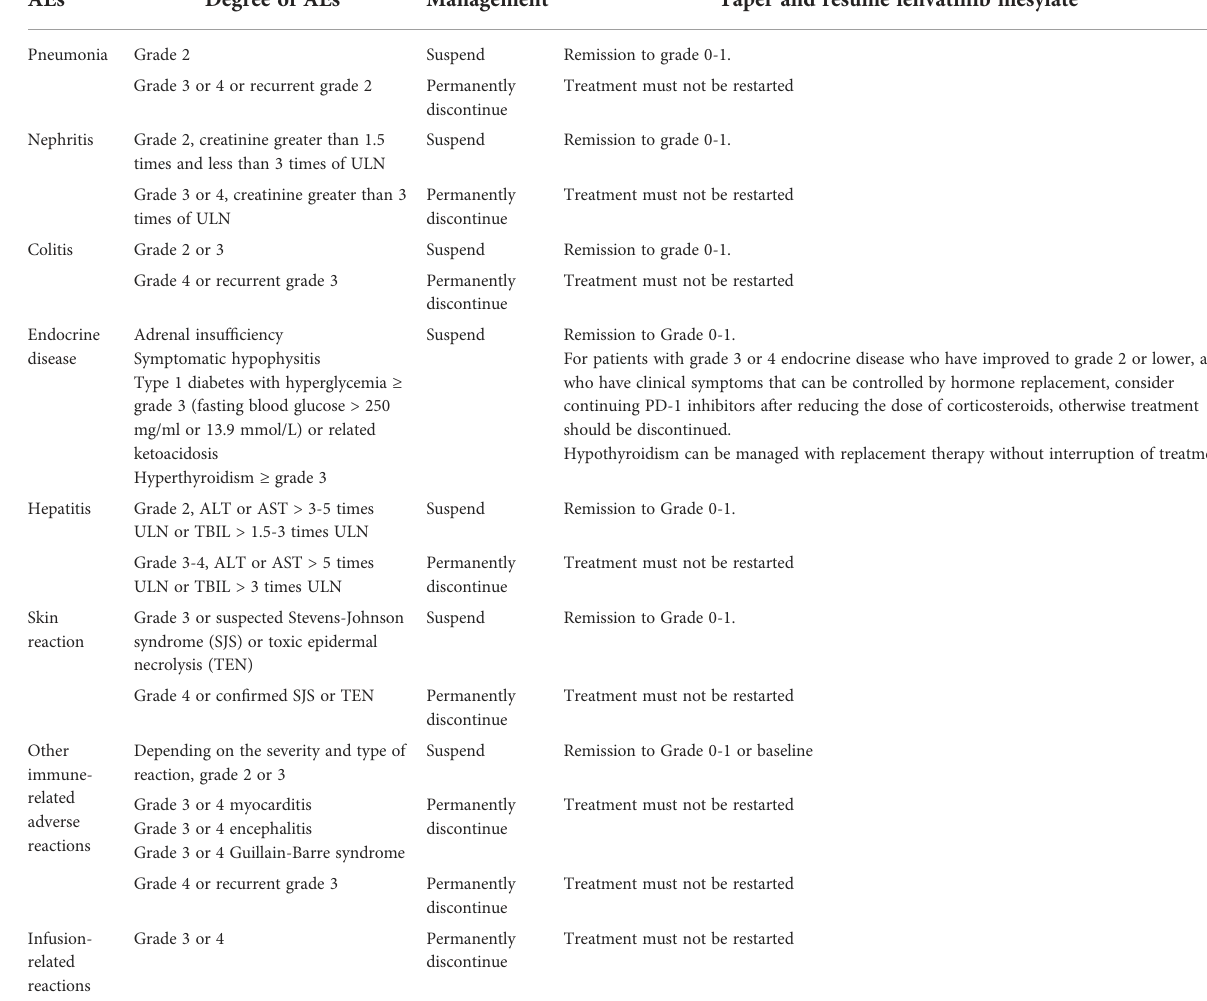
TABLE 3 Adjustment criteria of PD-1 inhibitor according to the